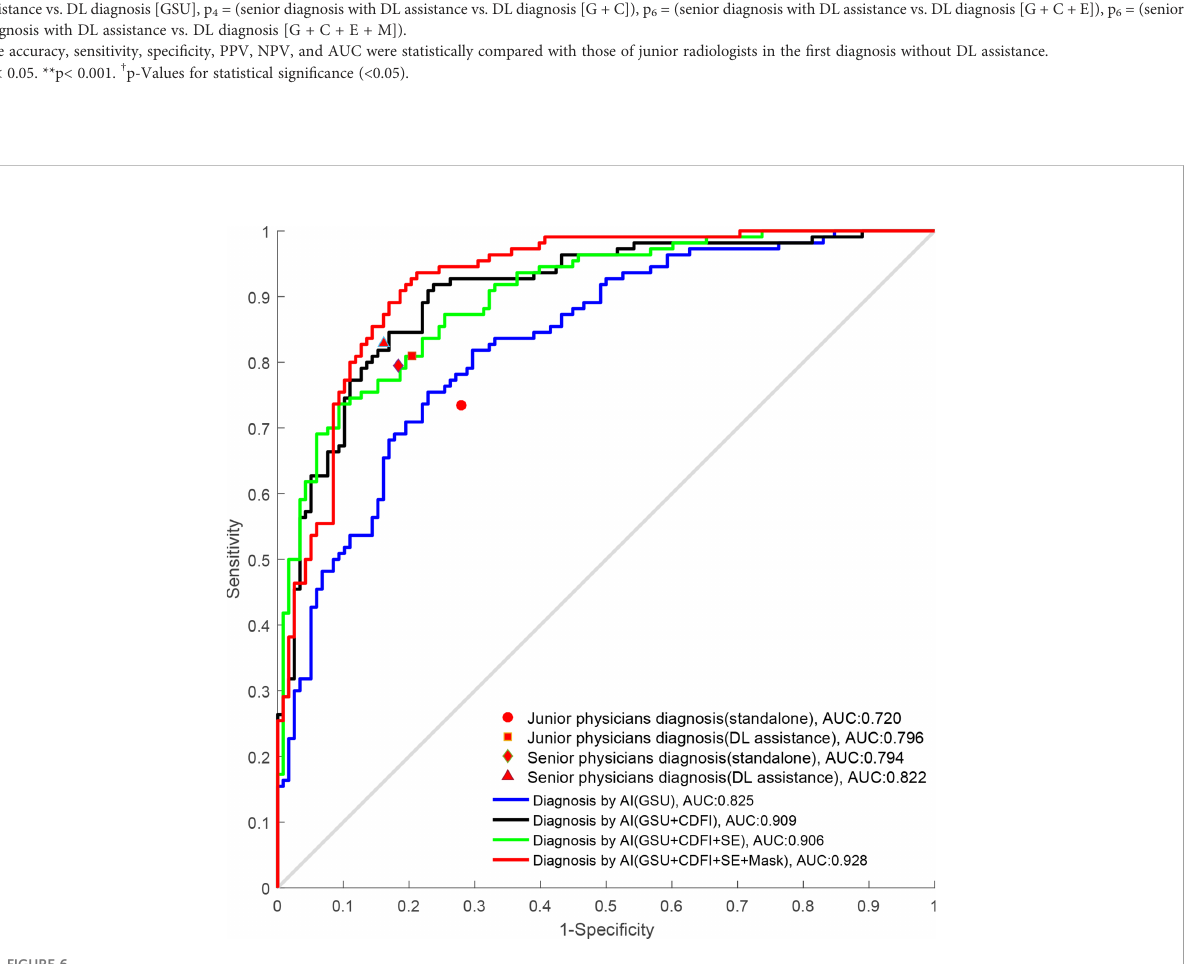
FIGURE 6 The ROC curves of DL and radiologists with different degrees of experience. ROC, receiver operating characteristics; DL, deep